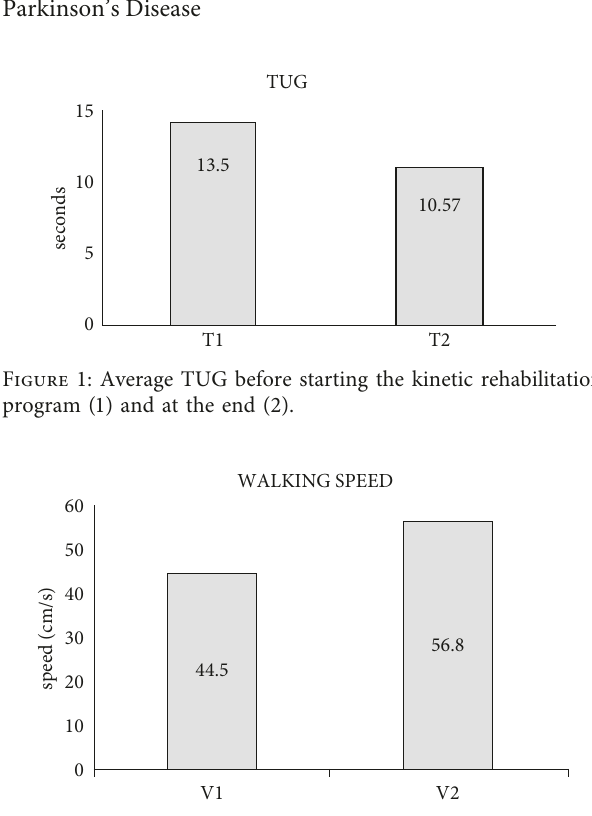
Figure 2: Average walking speed before starting the kinetic re- habilitation program (1) and at the end